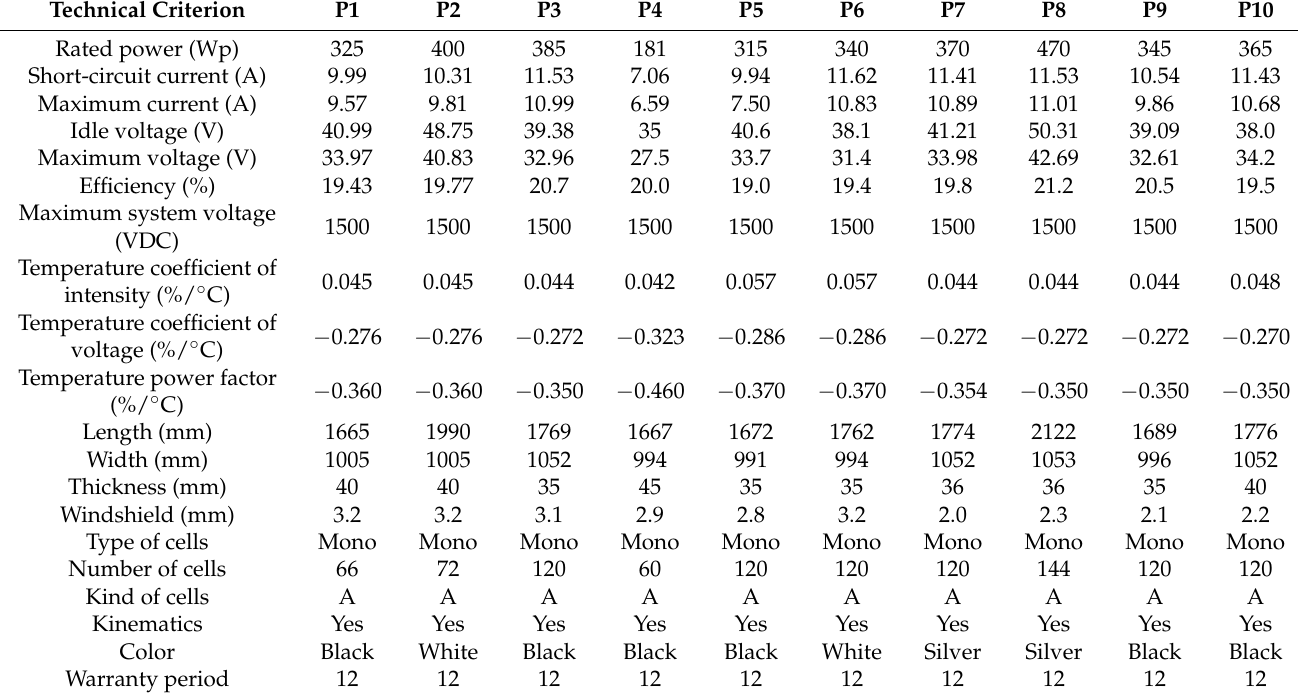
Table 5. Parameters of photovoltaic panels for expected technical